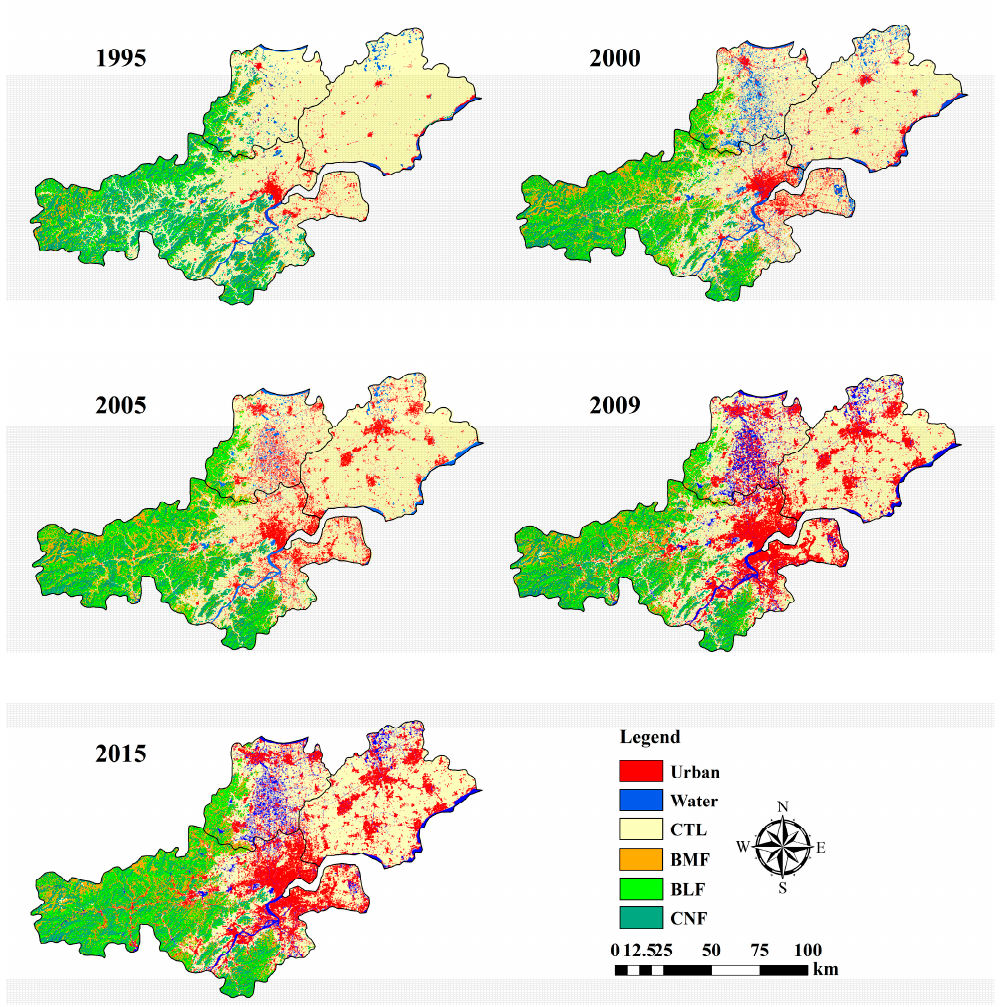
Figure 3. Land use classification map from 1995 to 2015.